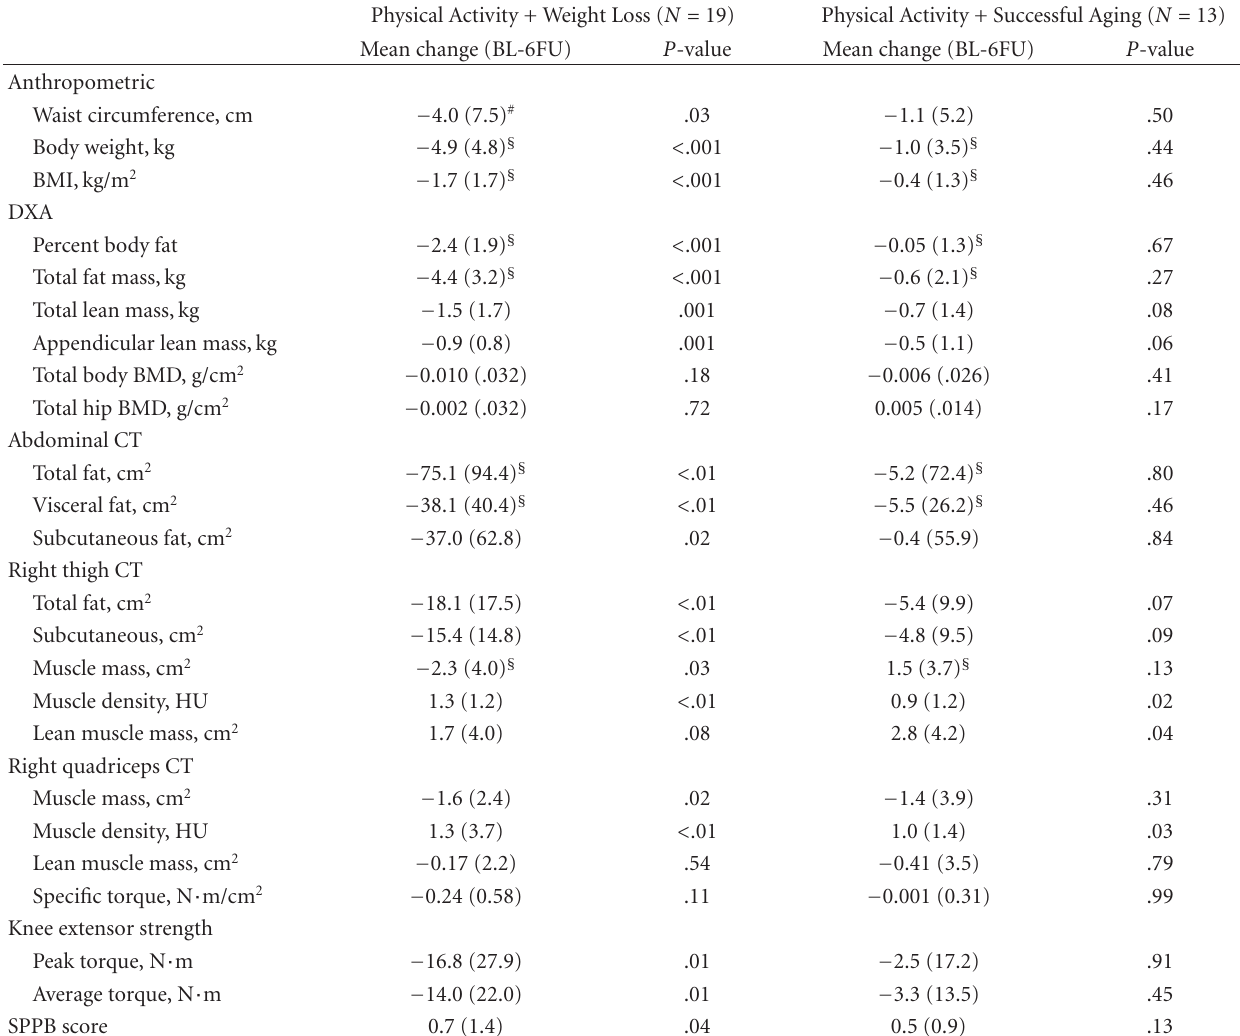
Table 3: Mean changes in anthropometric, body composition, bone mass, muscle strength, and physical function measures from baseline to 6-month followup by intervention group.